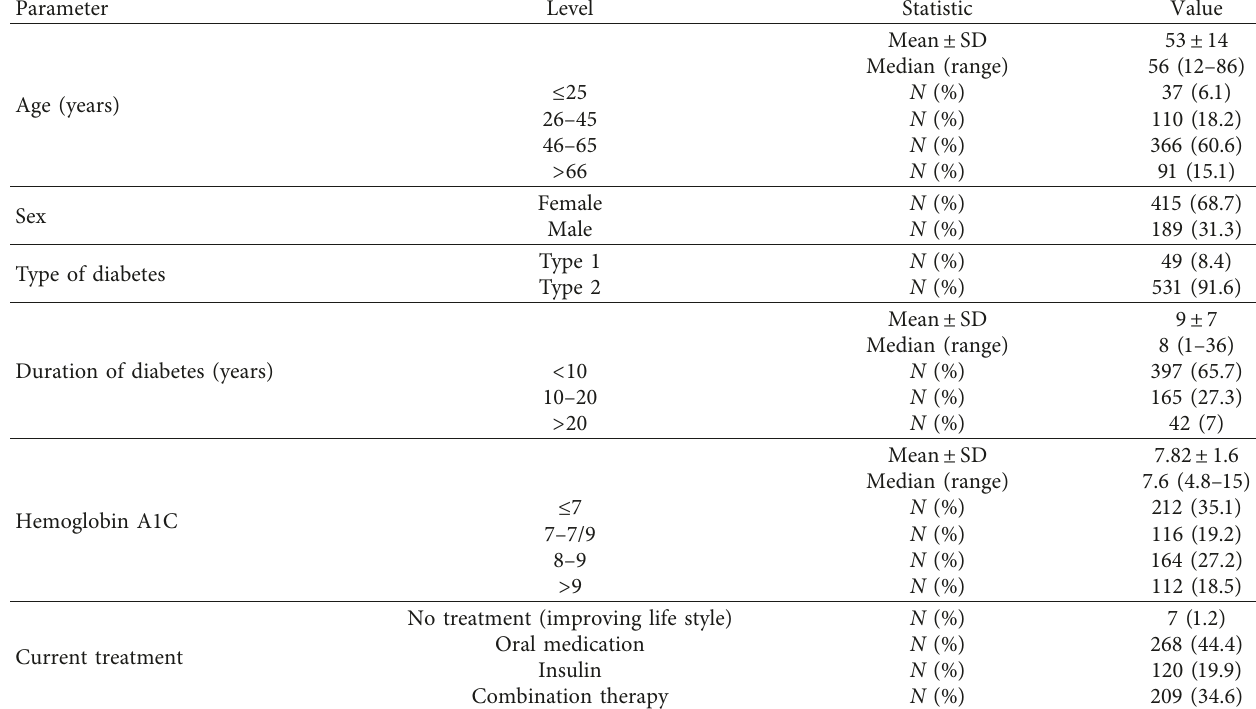
Table 1: Demographic characteristics and medical data of the screened subjects.